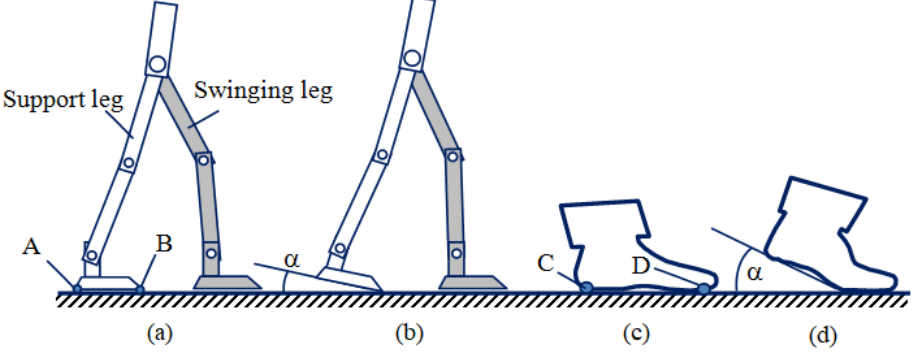
Figure 9. The robot state when the ZMP point is outside the support polygon.